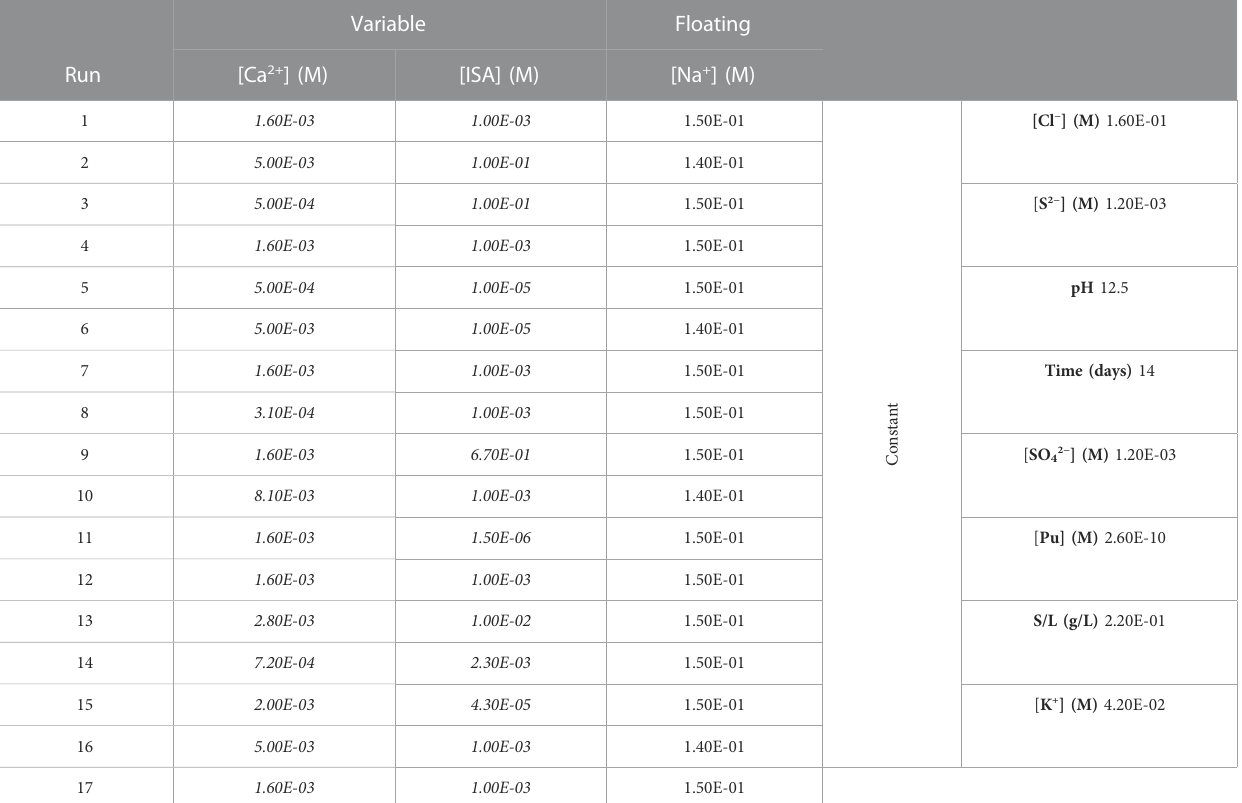
TABLE 4 Experimental plan for surface response measurement (SRM), based on Central Composite Design (CCD). Only the levels of [Ca 2+ ] and [ISA] are varied according to the experimental design. [Na] is a fl oating variable of which the levels are allowed to vary to allow mass balancing of the solutions. The other factors are kept constant throughout the 17